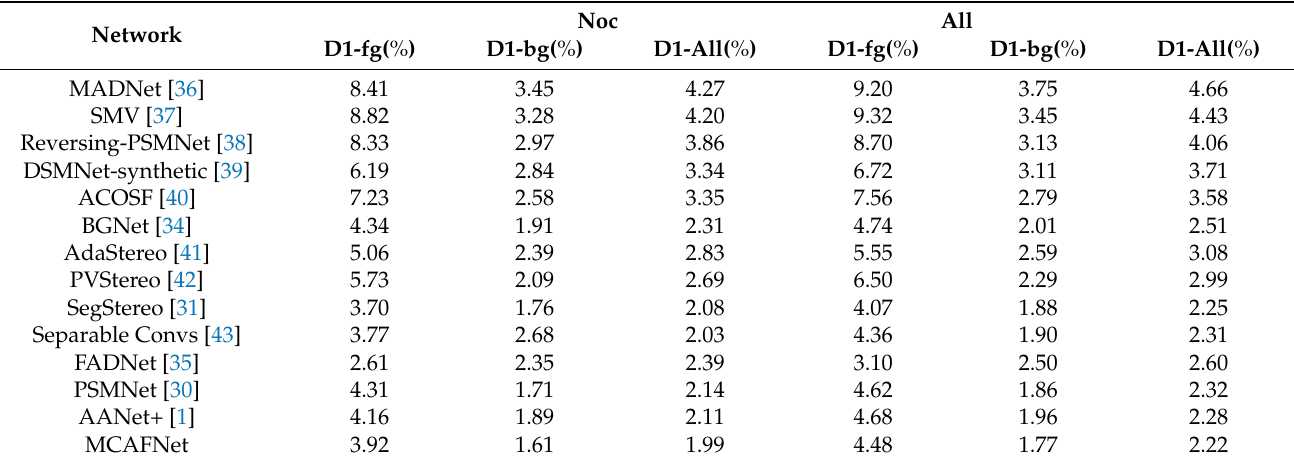
Table 5. Comparative experiment on the KITTI2015